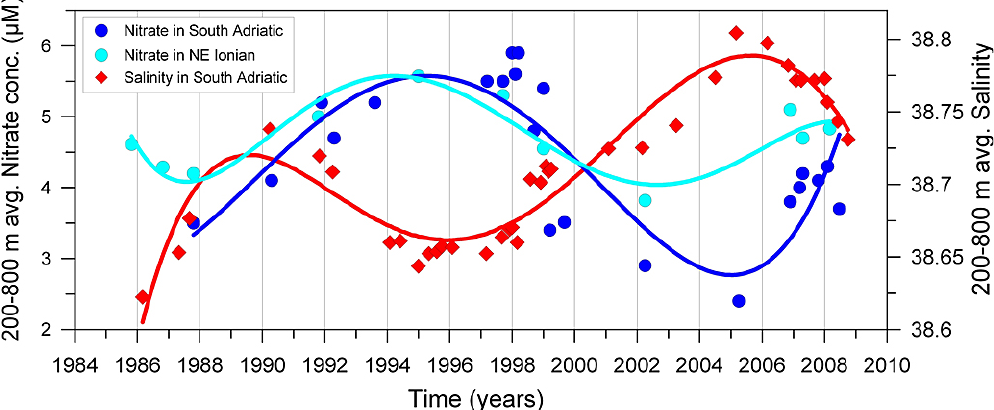
Fig. 2. Time series of salinity in the Southern Adriatic and nitrate in the Southern Adriatic and in the northeastern Ionian averaged over the depth of the 200–800m layer. For clarity, data are fitted by polynomial curves.